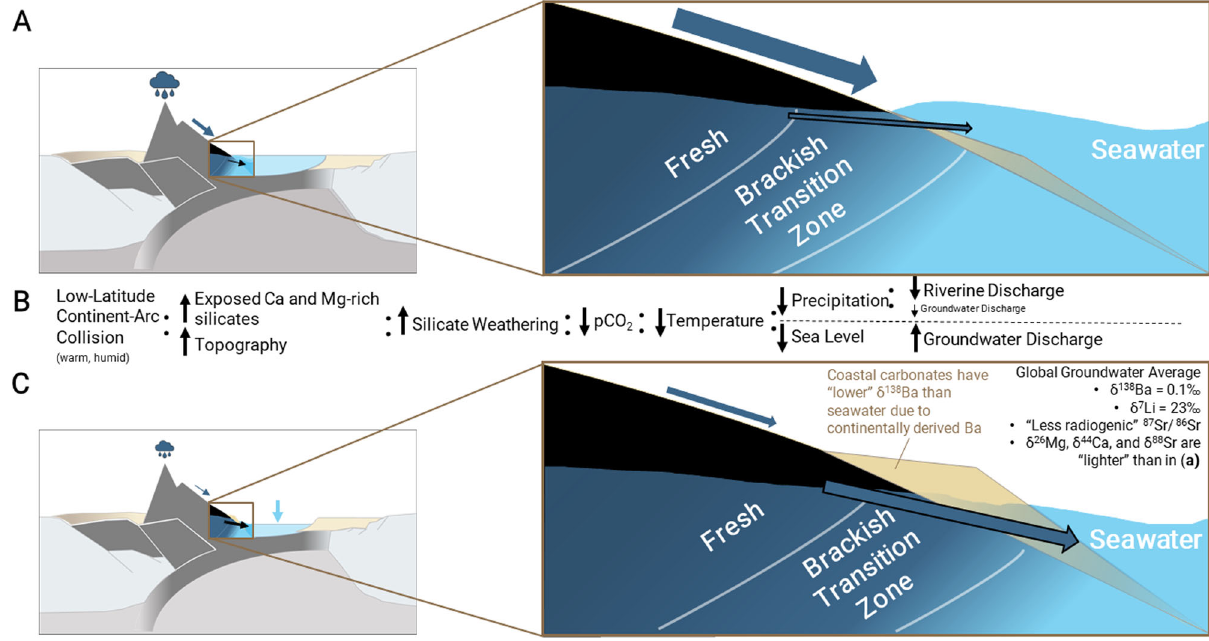
Fig. 4 Illustration of a subterranean estuary during a shift to glacial conditions. a Interglacial stage steady-state conditions with the subterranean estuary magni fi ed on the right. b Conceptual outline of the feedback outlined by Macdonald et al. 11 , where a low-latitude island arc collision instigates the onset of global cooling. c Glacial conditions with less precipitation and falling sea level with the subterranean estuary magni fi ed on the right and a description of the chemical changes that might occur to the isotopic composition of global groundwater-derived solute fl uxes. The tan triangle represents coastal carbonate deposits, whose δ 138 Ba composition may be lighter than seawater values if previously exposed to terrestrial (groundwater and river water)